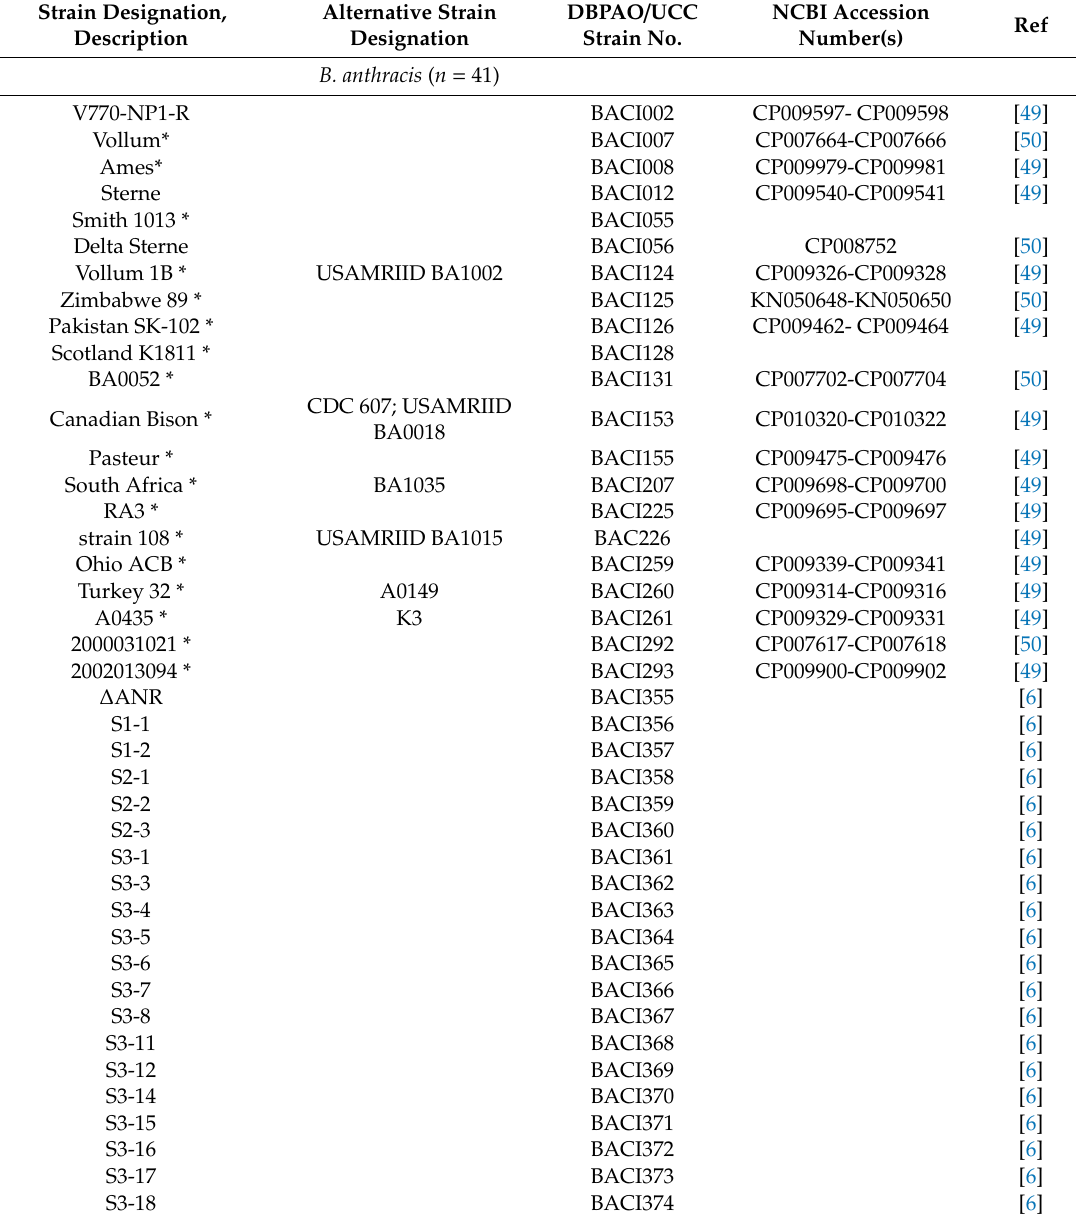
Table 12. B. anthracis strains used in this